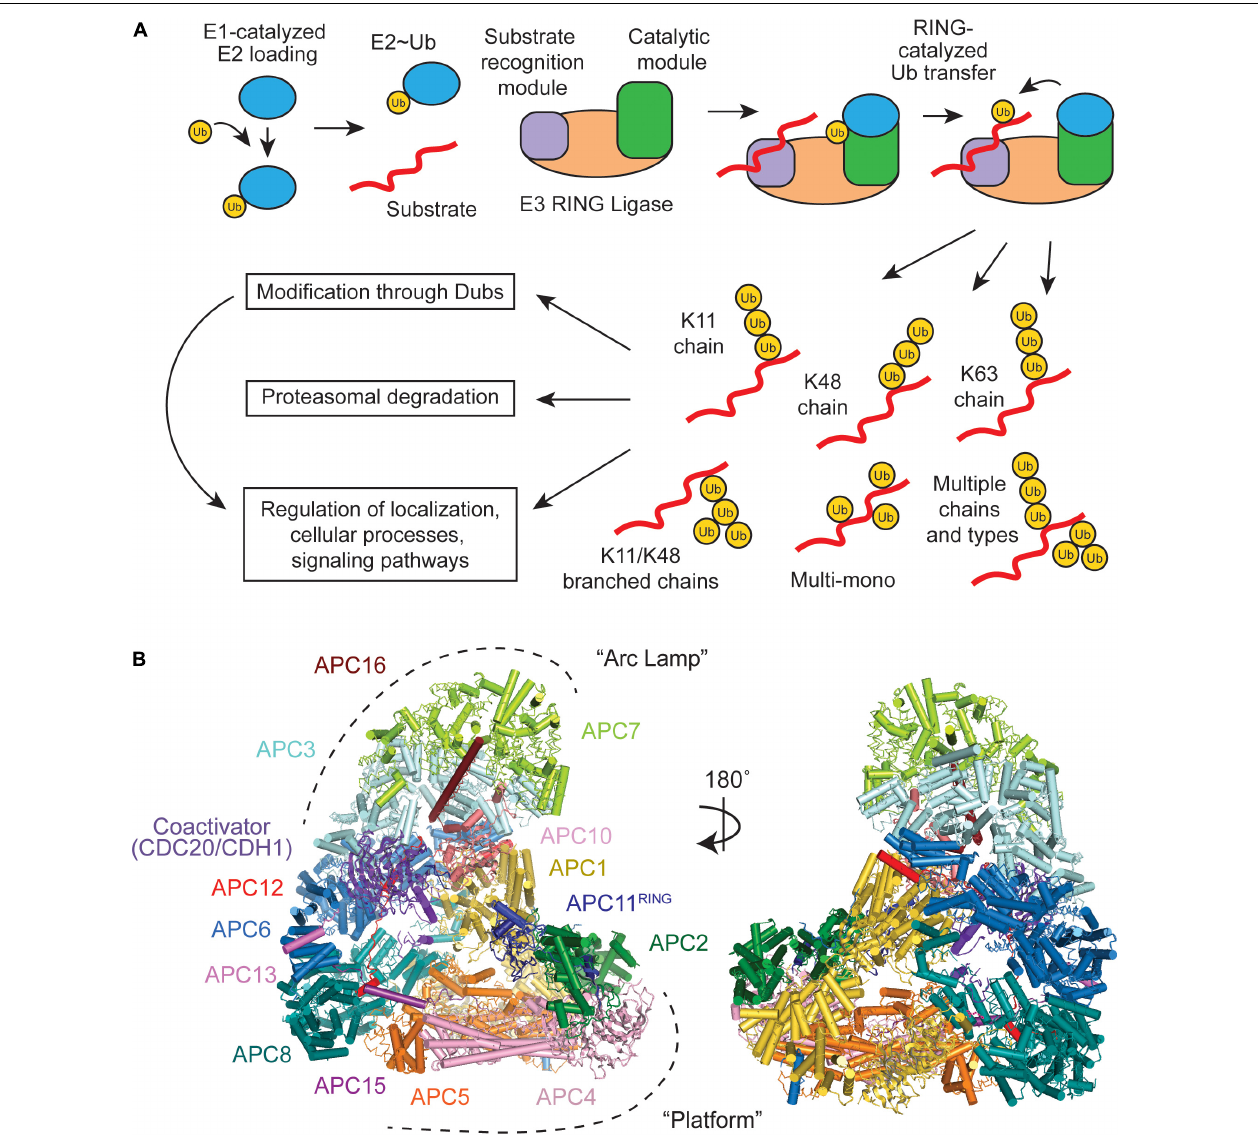
FIGURE 1 | Overview of a RING E3 Ub ligase mechanism and structural overview of the Anaphase-Promoting Complex/Cyclosome (APC/C). (A) Substrate ubiquitination occurs through an E1-E2-E3 cascade, with RING E3s containing both a receptor for recognizing substrates and catalytic domains that facilitate Ub transfer. Multiple E2 binding events result in an array of Ub chain types that have specific downstream effects. (B) The APC/C consists of 19 polypeptides, which can be broken down into two large subdomains, the “Arc Lamp” and the “Platform” (PDB ID code 5G04) (Zhang et al.,